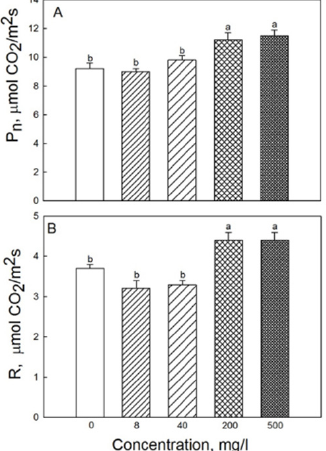
Figure 4. Effects of seed treatment with various concentrations of Fe 3 O 4 nanoparticles on the rate of ( A ) CO 2 assimilation and ( B ) respiration in third leaves of 19-day-old wheat plants grown at light intensity 120 µ mol (photons) m − 2 · s − 1 . Data are means ± SD ( n = 5). Data labelled with different lower-case letters are significantly different at p < 0.05.